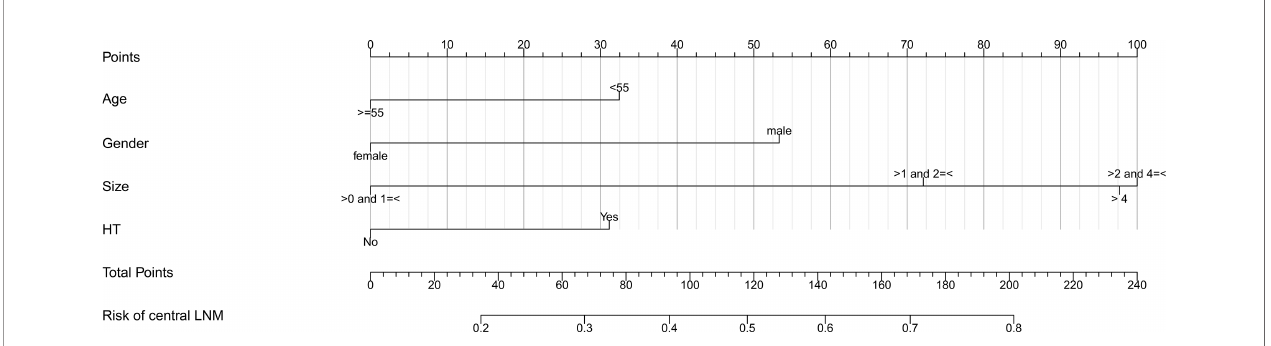
FIGURE 2 | Clinical factor-based nomogram used for predicting the CLNM in PTC patients. CLNM, central lymph node metastasis, HT, Hashimoto ’